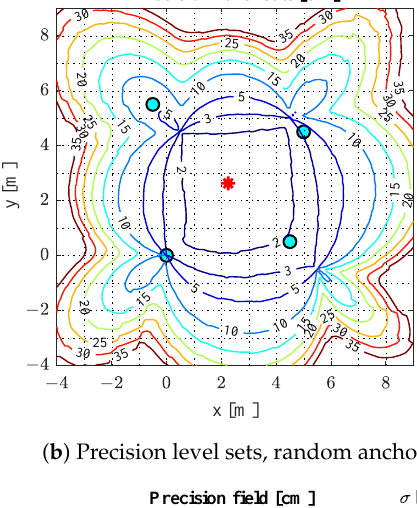
( a ) Precision level sets, symmetric anchors. ( b ) Precision level sets, random anchors.